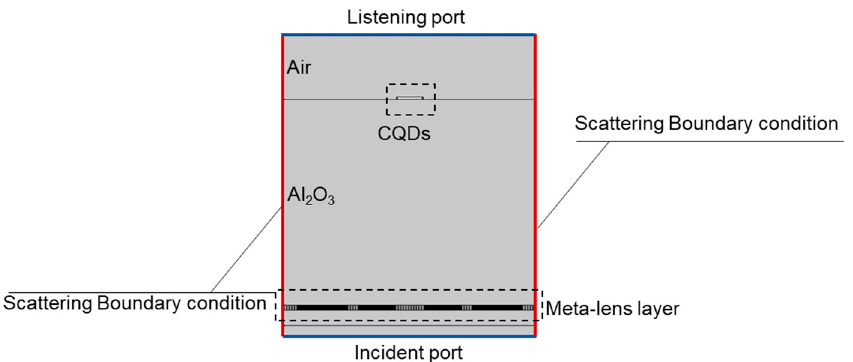
Figure 1. Simulation model of CQD detector integrated with a meta-lens.